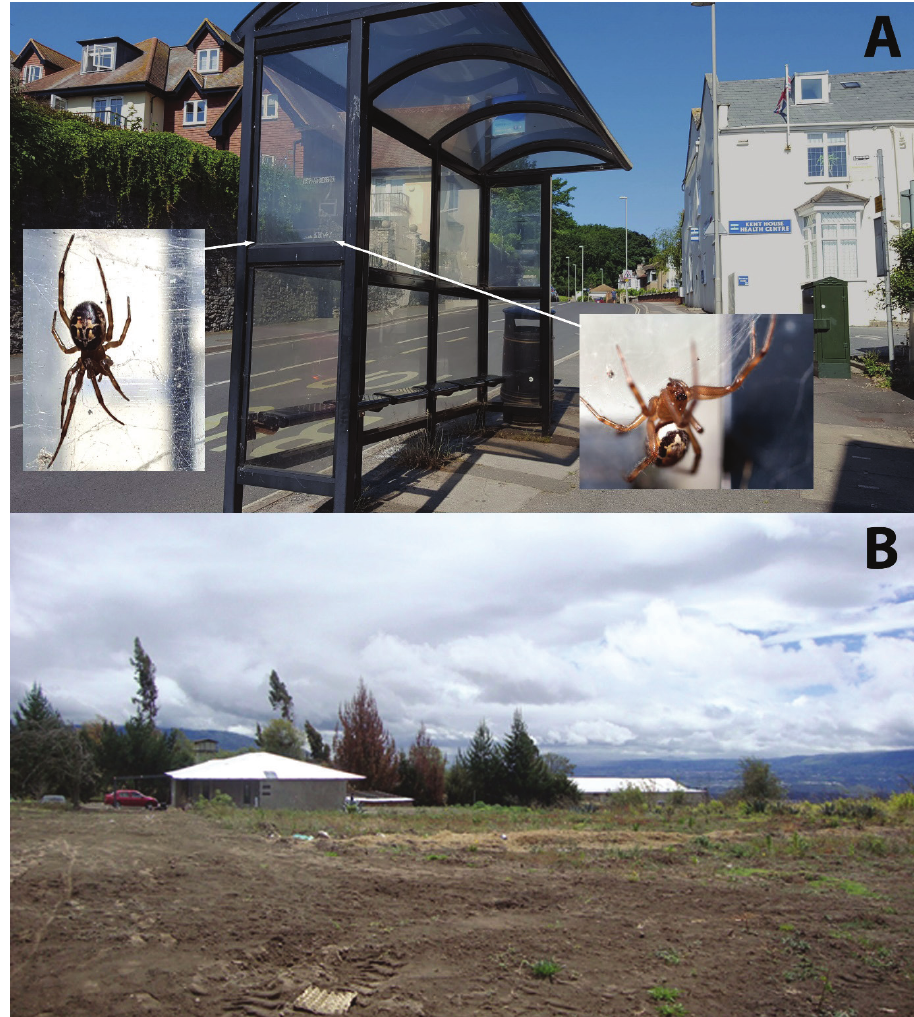
Figure 1. Diversity of habitats of Steatoda nobilis in its invasive range. A In the South of England, the species is not only abundant on stone walls and railings along the sea side, but also on man-made struc- tures further inland, such as this bus stop in the coastal resort of Lyme Regis, Dorset, where its webs (inset) typically occur together with those of Zygiella x-notata (Araneidae) B Vicinity of the localities with records of S. nobilis in Ambato-Montalvo (Ecuador), August